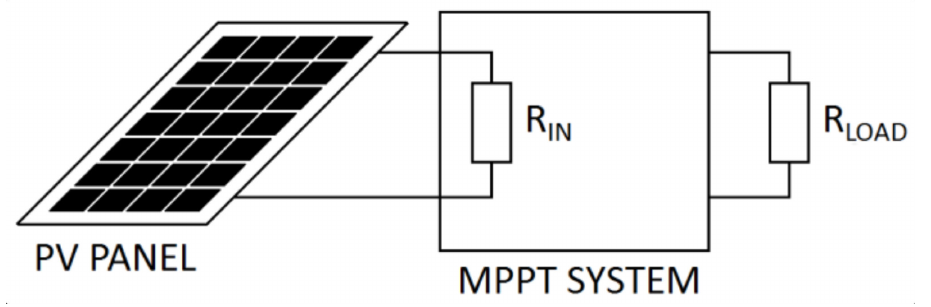
Figure 1. The structure of an MPPT